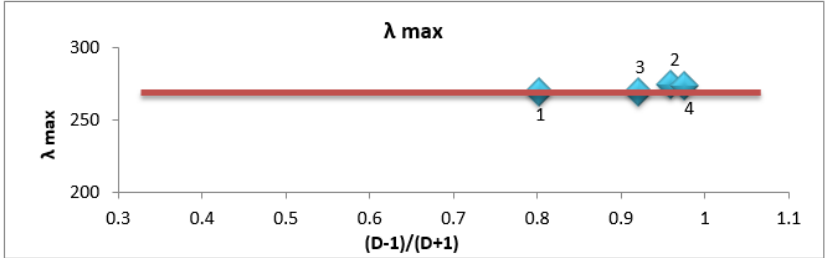
Fig. 4. The relation between the dipole moment constants and the maximum wavelengths of (A 1 ) using different solvents (1- Chloroform , 2- DMSO, 3- Ethanol, 4-